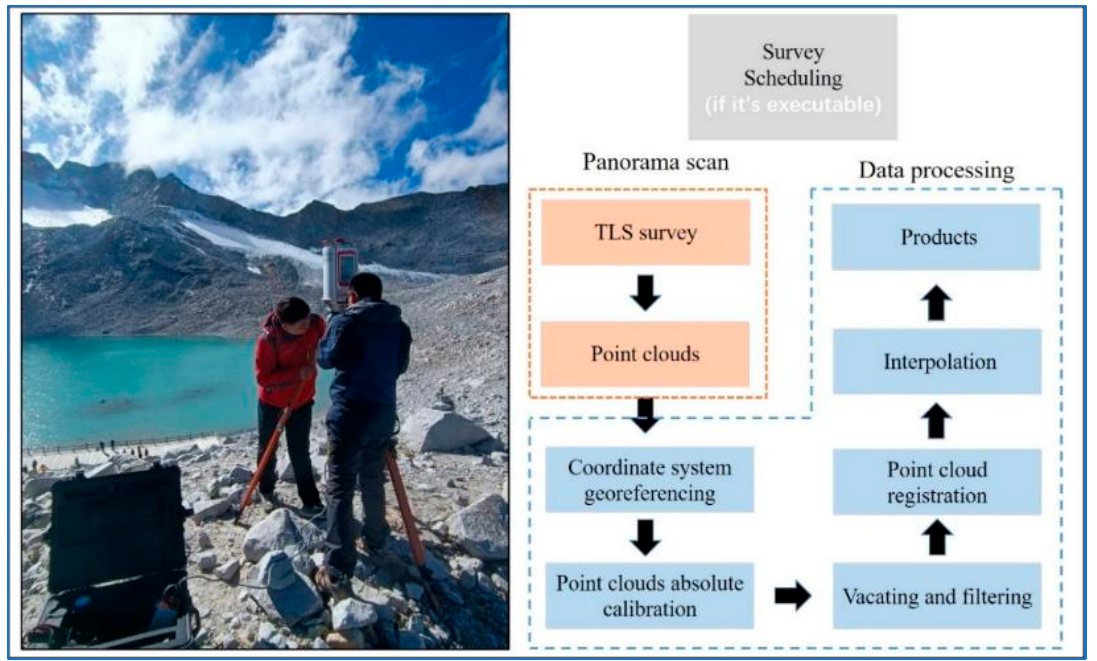
Figure 3. TLS fine scanning of DG17 with the Riegl VZ ® -6000 terrestrial laser scanner ( left ) and process of point cloud data processing ( right ).